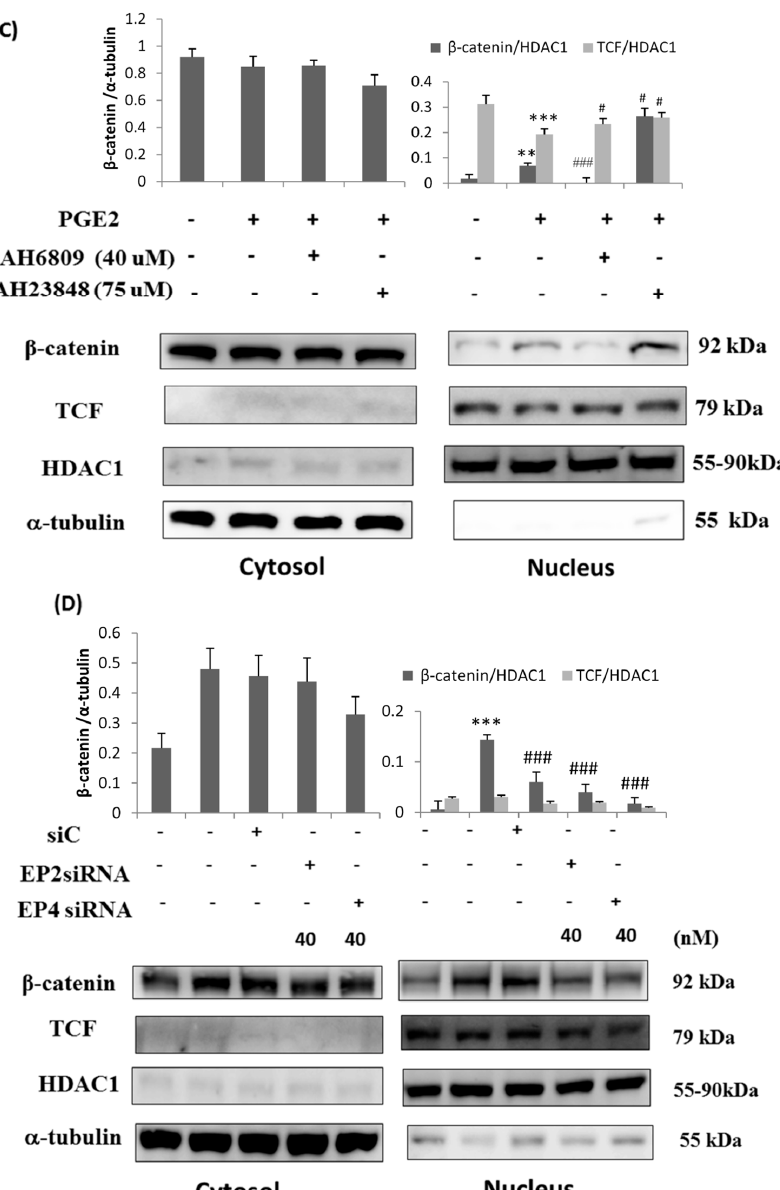
Figure 4. Prostaglandin E2 (PGE2) treatment caused the translocation of β -catenin from the cytosol to the nucleus in LoVo cell. LoVo cells were pretreated with ( A ) the EP2 antagonist AH6809 or the EP4 antagonist AH23848 or ( B ) EP2 siRNA or EP4 siRNA, and then treated with PGE2 (5 μ M). Immunofluorescence assays were performed in LoVo cells using an antibody against β -catenin (1:250, green stain, Red arrows) followed by 4 ′ ,6-diamidino-2-phenylindole DAPI nuclear counterstaining (blue). The merged images of β -catenin (green) with DAPI (blue) are also shown. In addition, the cytosolic and nuclear proteins were isolated from LoVo cells pretreated with ( C ) the EP2 antagonist AH6809 or the EP4 antagonist AH23848 or ( D ) EP2- or EP4-specific siRNA and treated with PGE2 (5 μ M). The expression of β -catenin, LEF-1, TCF-4 and HDAC1 was detected by immunoblot assay. ** p < 0.01 and *** p < 0.001 denotes significant differences from control values # p < 0.05 and ### p < 0.001 denote significant differences when compared to PGE2 treated groups. The results were presented as the mean ± SD of three difference experiments.